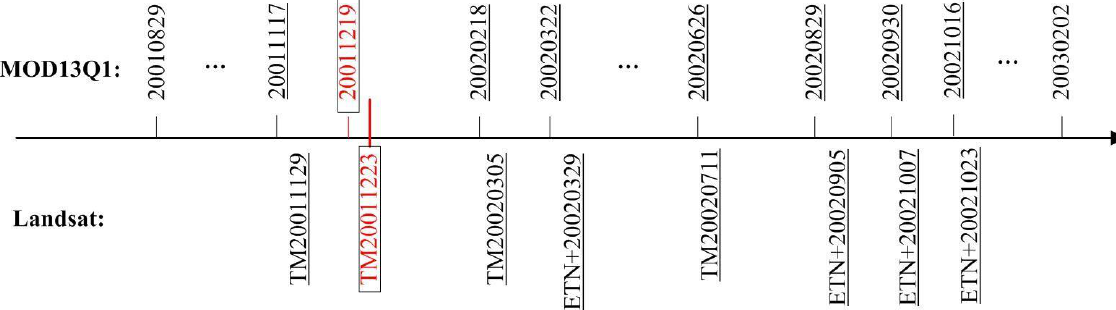
Figure 2. Acquisition dates of Landsat and MODIS scenes used for this study. The Landsat image at base date (23 December 2001) and the corresponding MOD13Q1 image at base date (the 23rd composite in 2001) are marked with red squares. The reference Landsat images for validation and their corresponding MOD13Q1 images are marked with underlines.